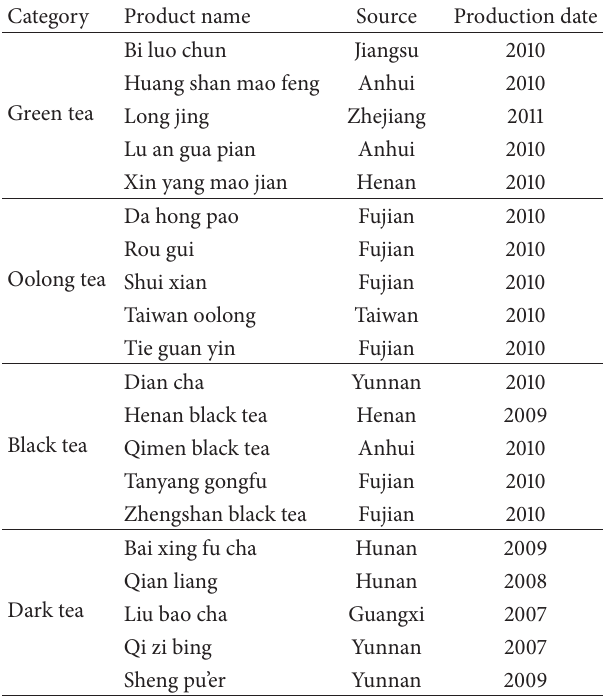
Table 1: Source and production date of 20 tea